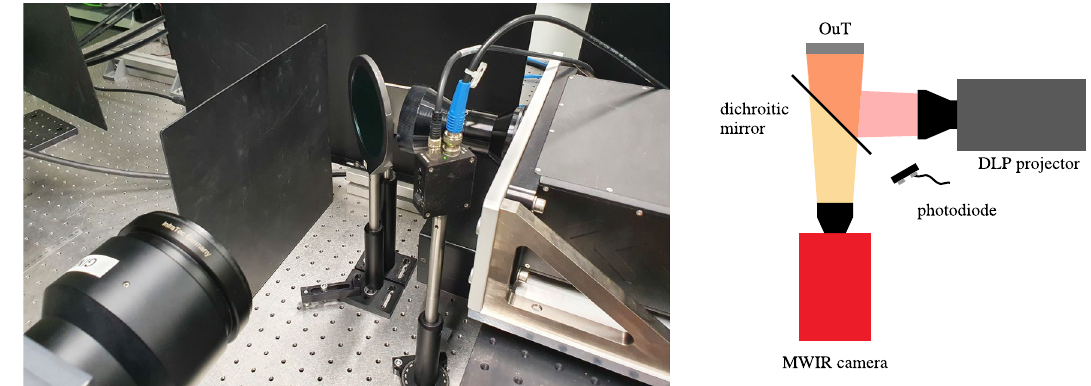
Figure 5. Experimental Setup: A laser-coupled DLP projector (right) projects different illumination patterns via a dichroic mirror (middle) onto the OuT (middle, background) while the resulting change in front surface temperature is recorded via a midwave infrared (MWIR) camera (bottom left). A photodiode (middle, foreground) is detecting when the patterns are projected and triggers the camera to start